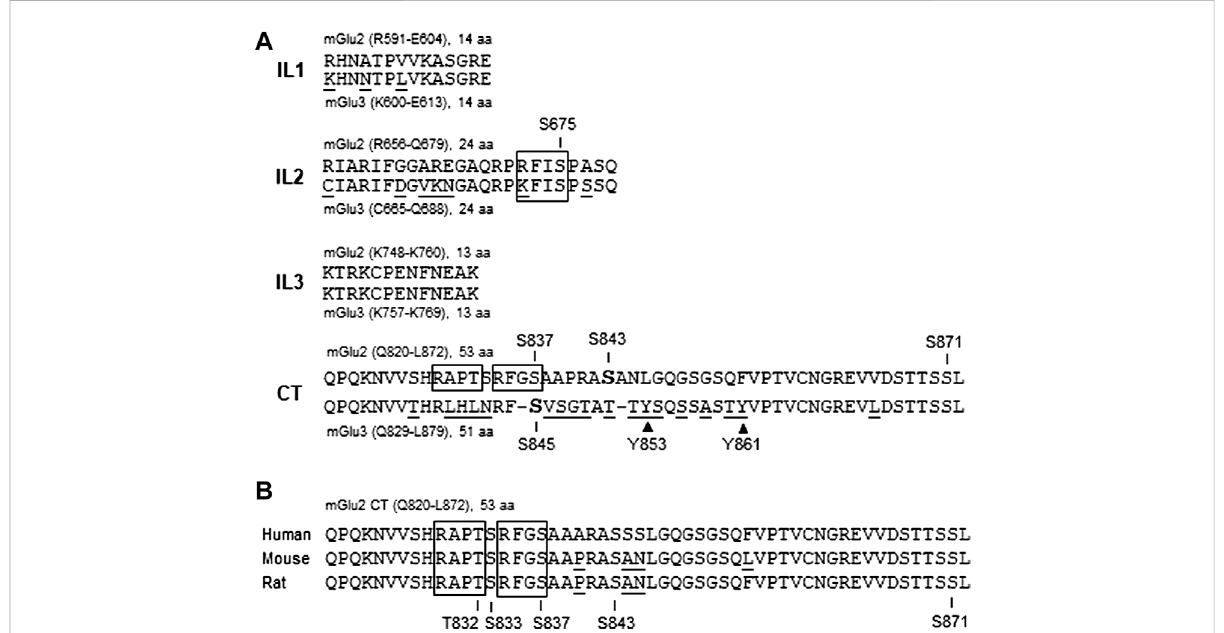
FIGURE 2 Alignment of amino acid sequences of intracellular domains between mGlu2 and mGlu3 subtypes and among three species. (A) Sequence alignment of intracellular domains between mGlu2 versus mGlu3 receptors. Intracellular domains include the intracellular loop 1 (IL1), IL2, IL3, and C-terminus (CT). Gaps ( – )are inserted inthe mGlu3 CT region to achieve maximum homolog. Note that the mGlu3 CT region contains two tyrosine residues (Y853 and Y861) indicated by solid triangles. (B) Sequence alignment of the CT regions among human, mouse, and rat mGlu2 orthologs. Note that the S843 residue is conserved in the three species. Underlined amino acids denote differences in sequence alignment. Open boxes indicate CaMKII consensus phosphorylation